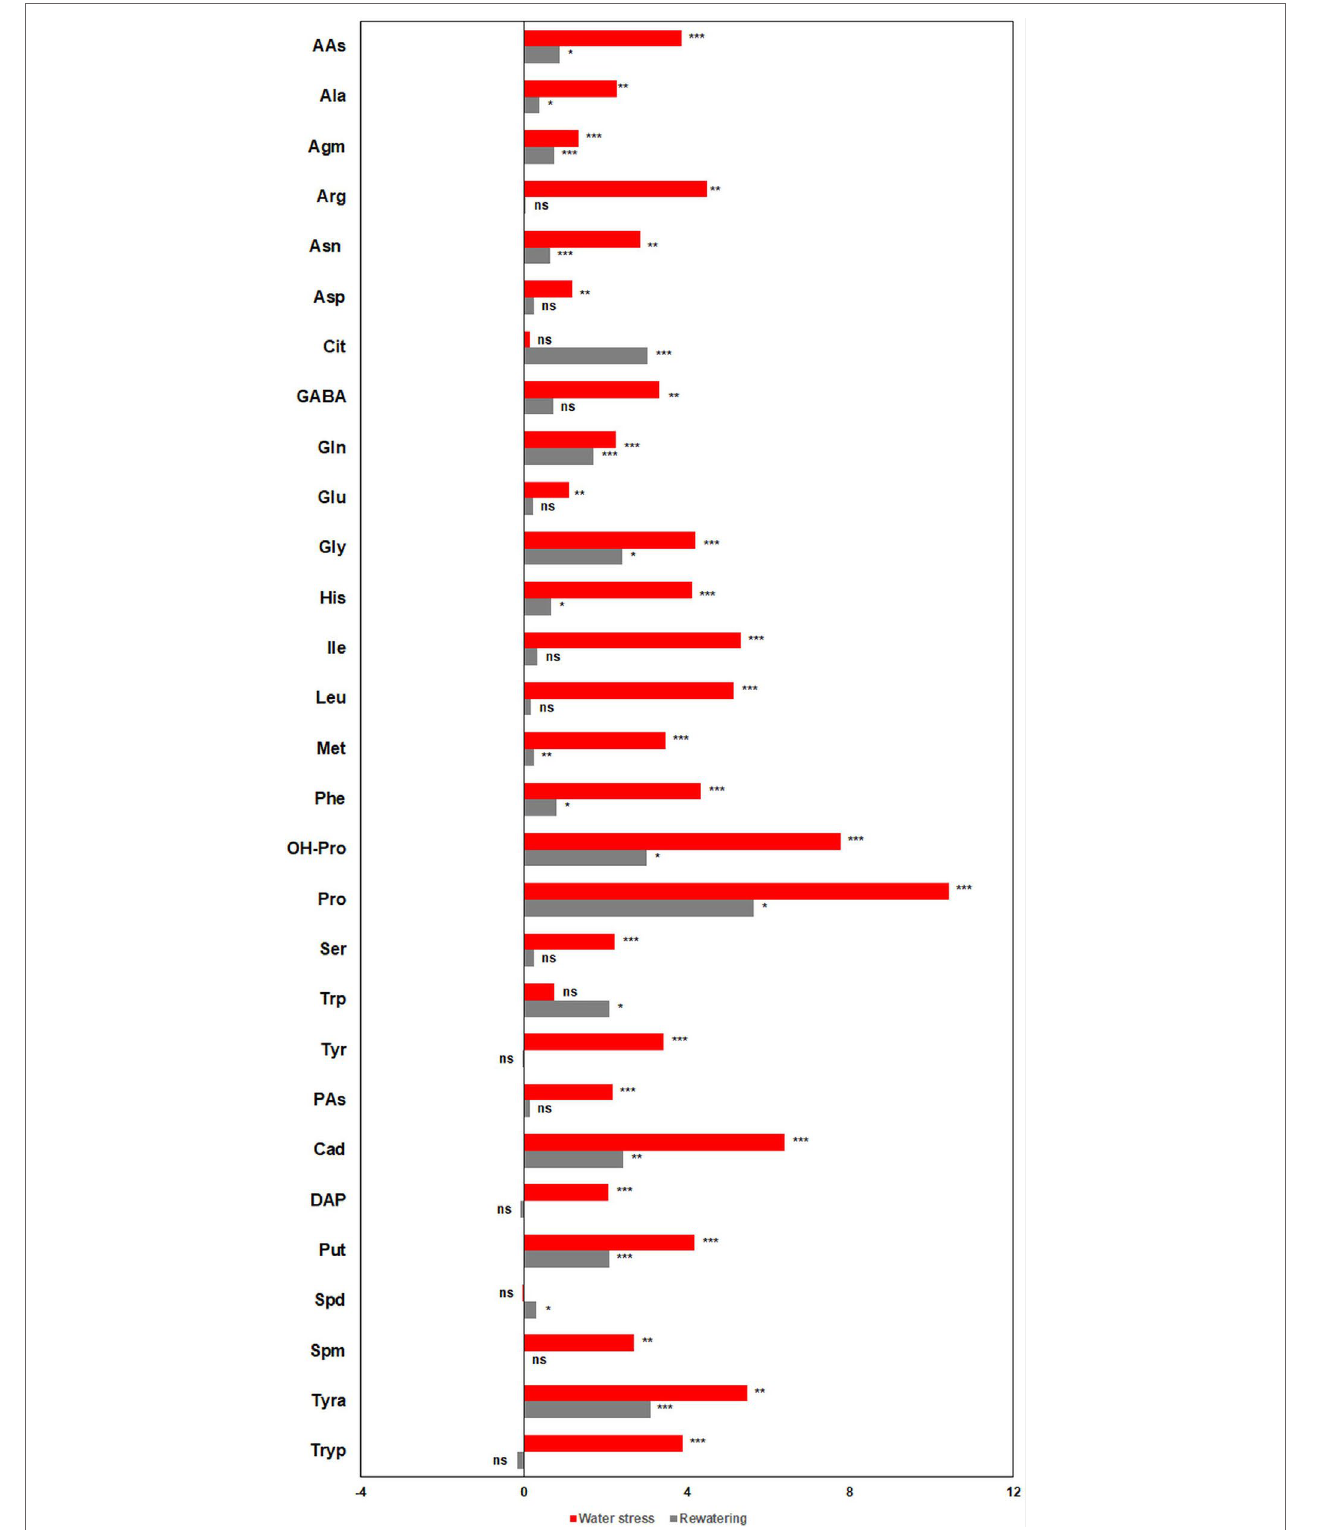
FIGURE 8 | Metabolic profiles of barley ( Hordeum vulgare ) seedlings under water deficit and after subsequent rewatering. Fold changes (presented as log 2 ratio) in the content (pmol mg -1 DW) of free polyamines (PAs) and amino acids (AAs) between stressed (D) and non-stressed (W) barley seedlings (three independent pools containing five plants from two independent trays, n = 6) at the end of the stress period (red bars) and after subsequent rewatering (gray